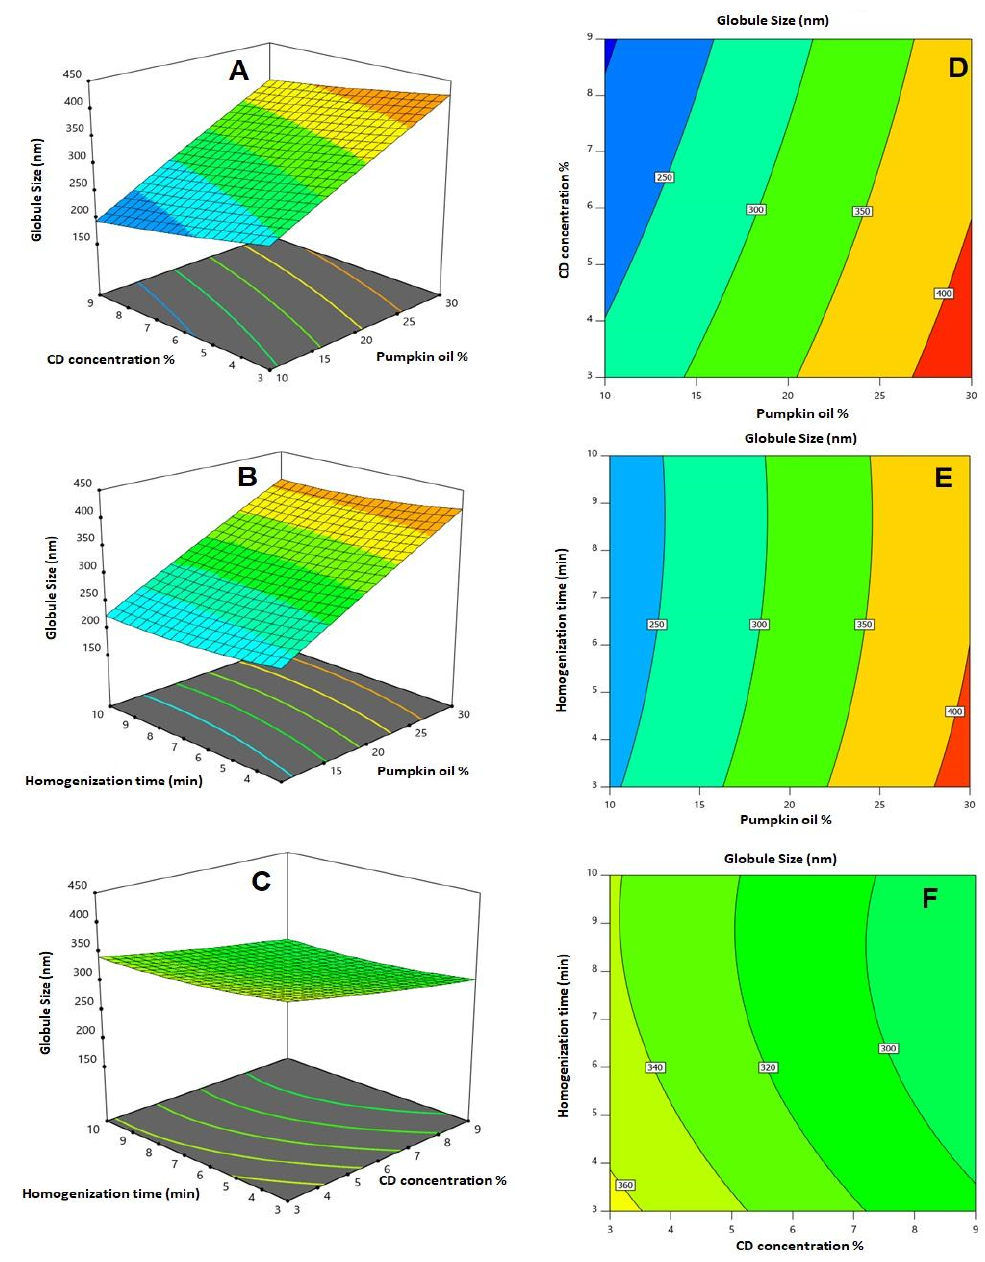
Figure 2. 2D contour plots ( A – C ) and 3D surface plots ( D – F ) for the influence and interactions of pumpkin oil concentration (X 1 ), α -CD concentration (X 2 ), and homogenization time (X 3 ) on the globule size of CTD-loaded